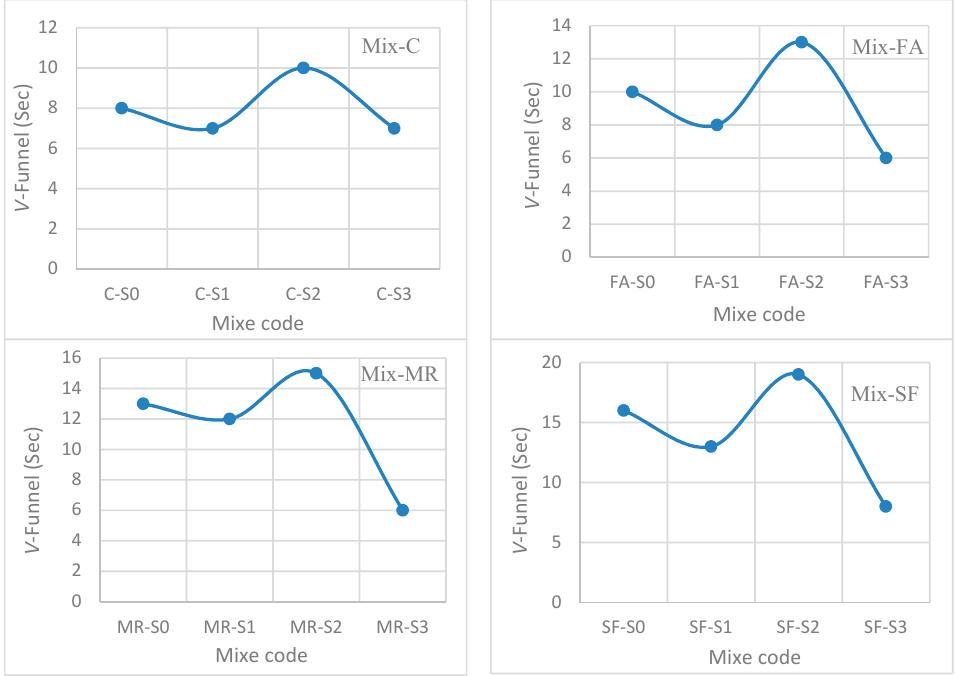
Figure 3. V -funnel results of all SFR ‒ SCC groups.